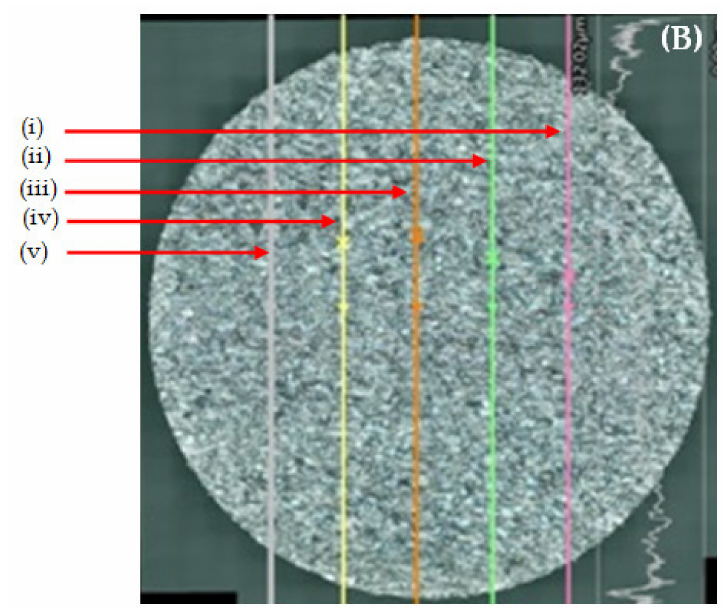
Figure 5. ( A ) Wire-travel direction; ( B ) surface analysis for sample at outer surface.